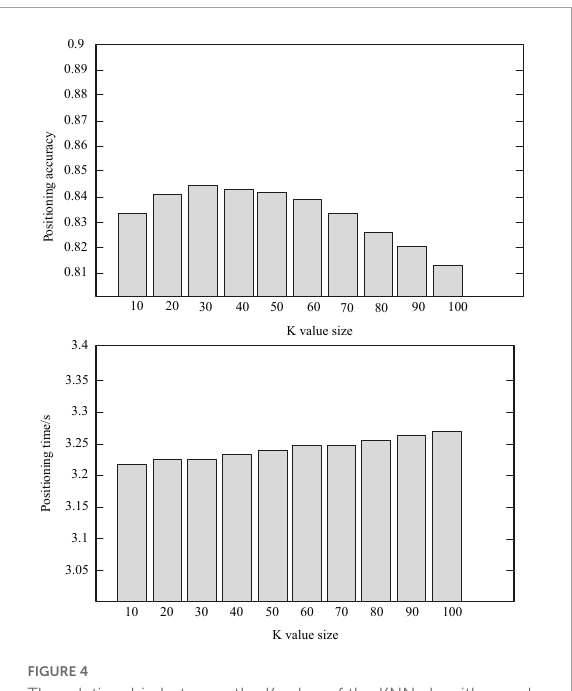
FIGURE4 The relationship between the K value of the KNN algorithm and the positioning speed and accuracy.